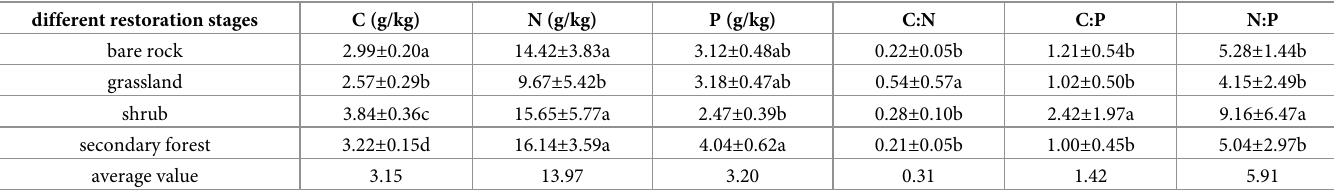
Different lowercase letters in the same column indicate significant differences between different habitats (P < 0.05).